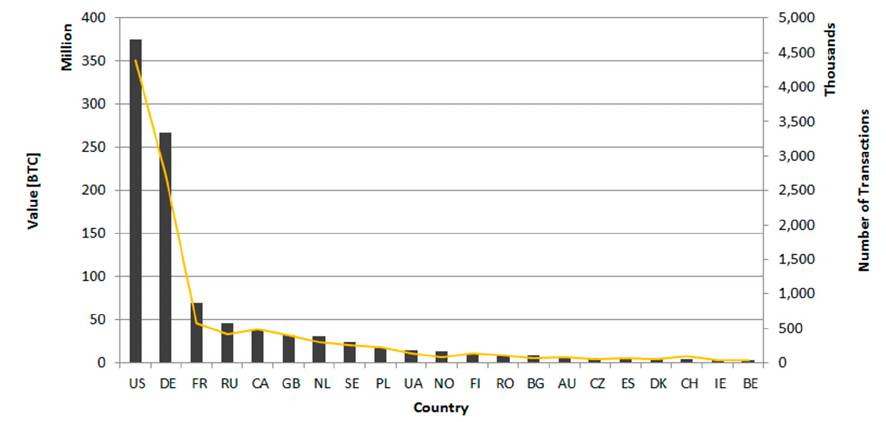
Figure 12. Number of Transactions and Value in BTC per Country.